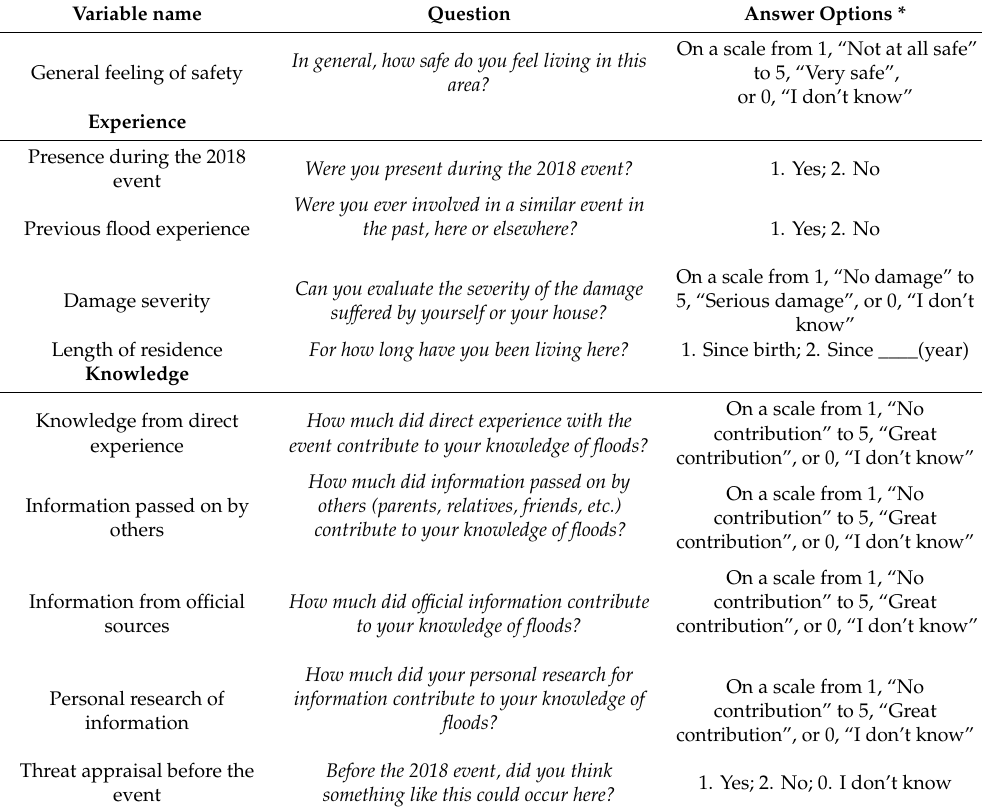
Table 1. Independent variables.